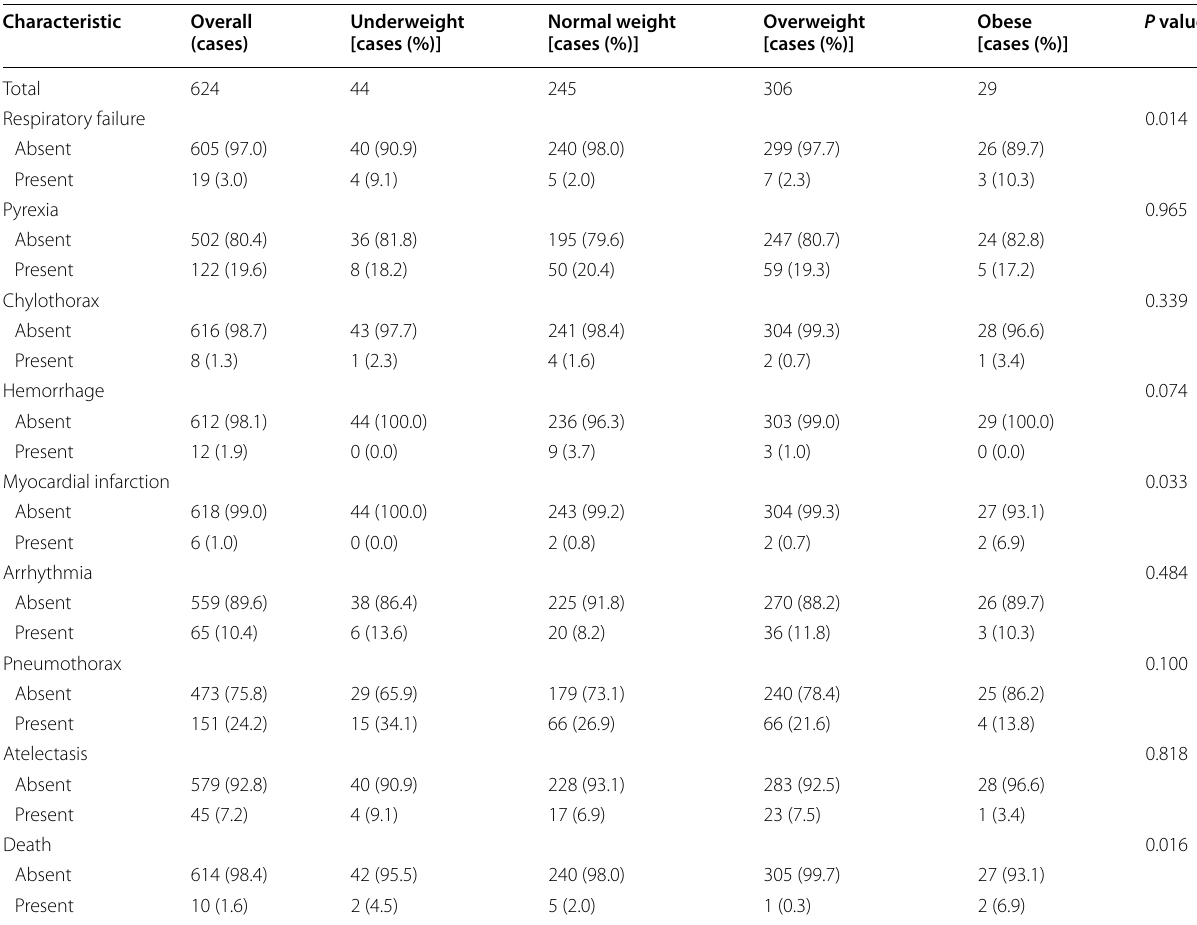
Table 2 Postoperative complications of underweight, normal weight, overweight, and obese patients with stage I NSCLC